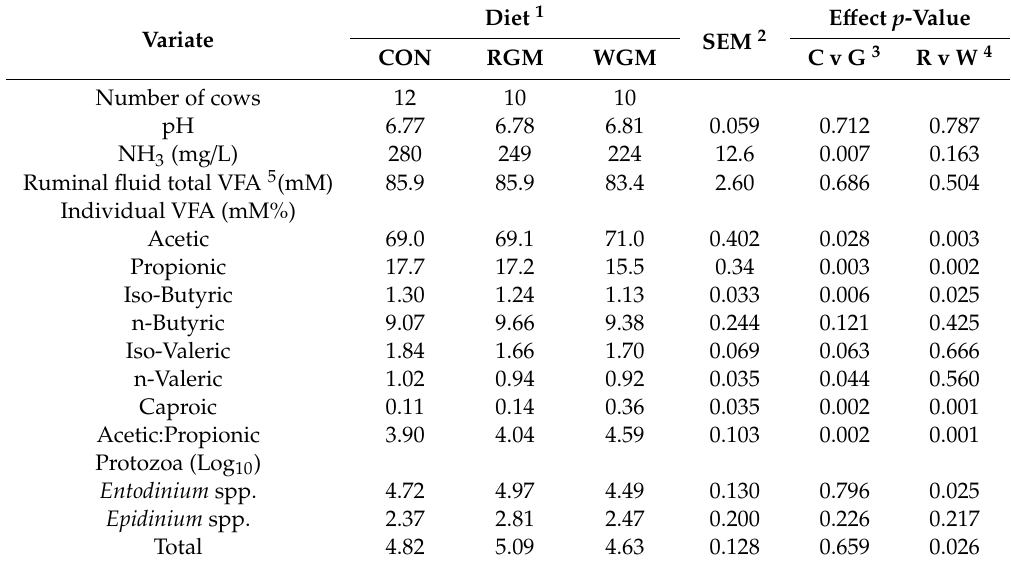
Table 8. Influence of diet on concentrations in rumen fluid of ammonia, total volatile fatty acids (VFAs), individual VFAs and rumen